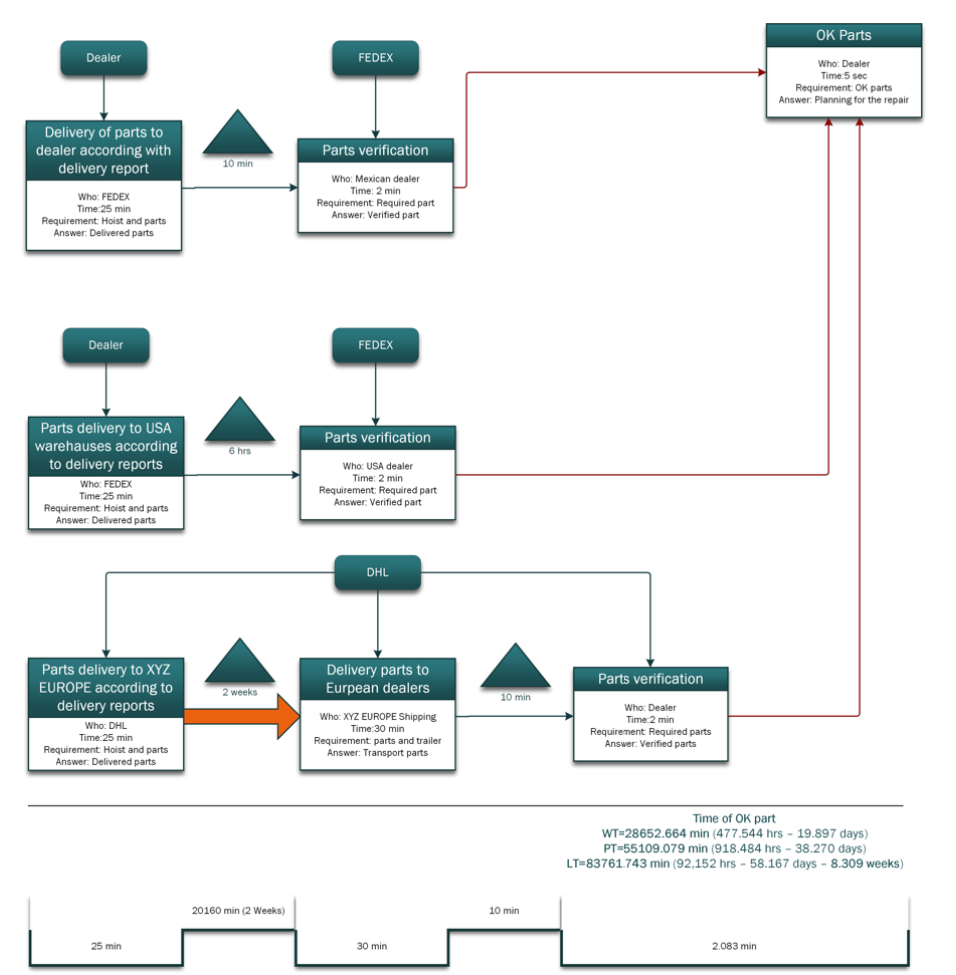
Figure 7. The fifth part of seven of the Current VSM is displayed. Appl. Sci. 2019 , 9 , x FOR PEER REVIEW